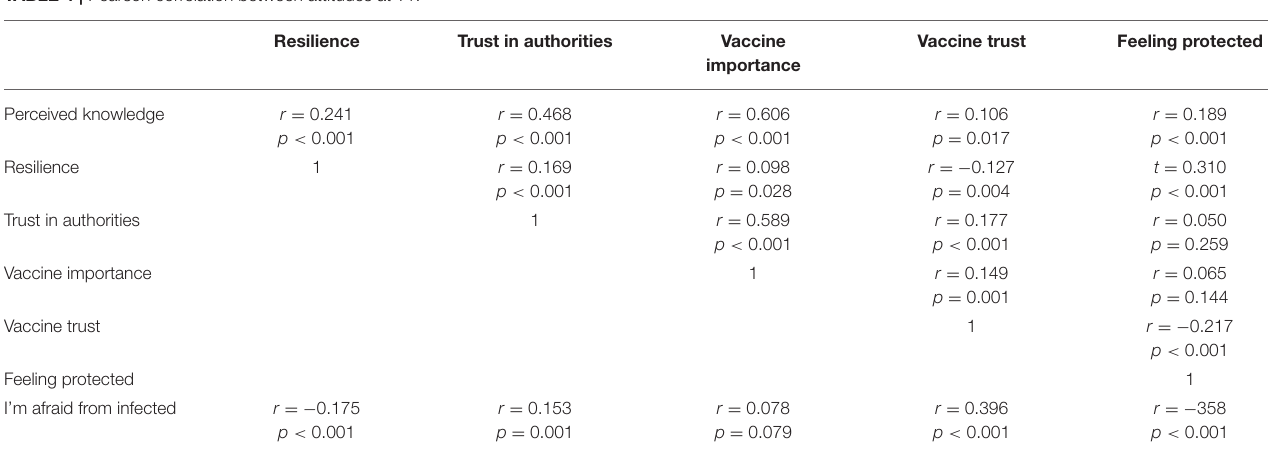
TABLE 4 | Pearson correlation between attitudes at